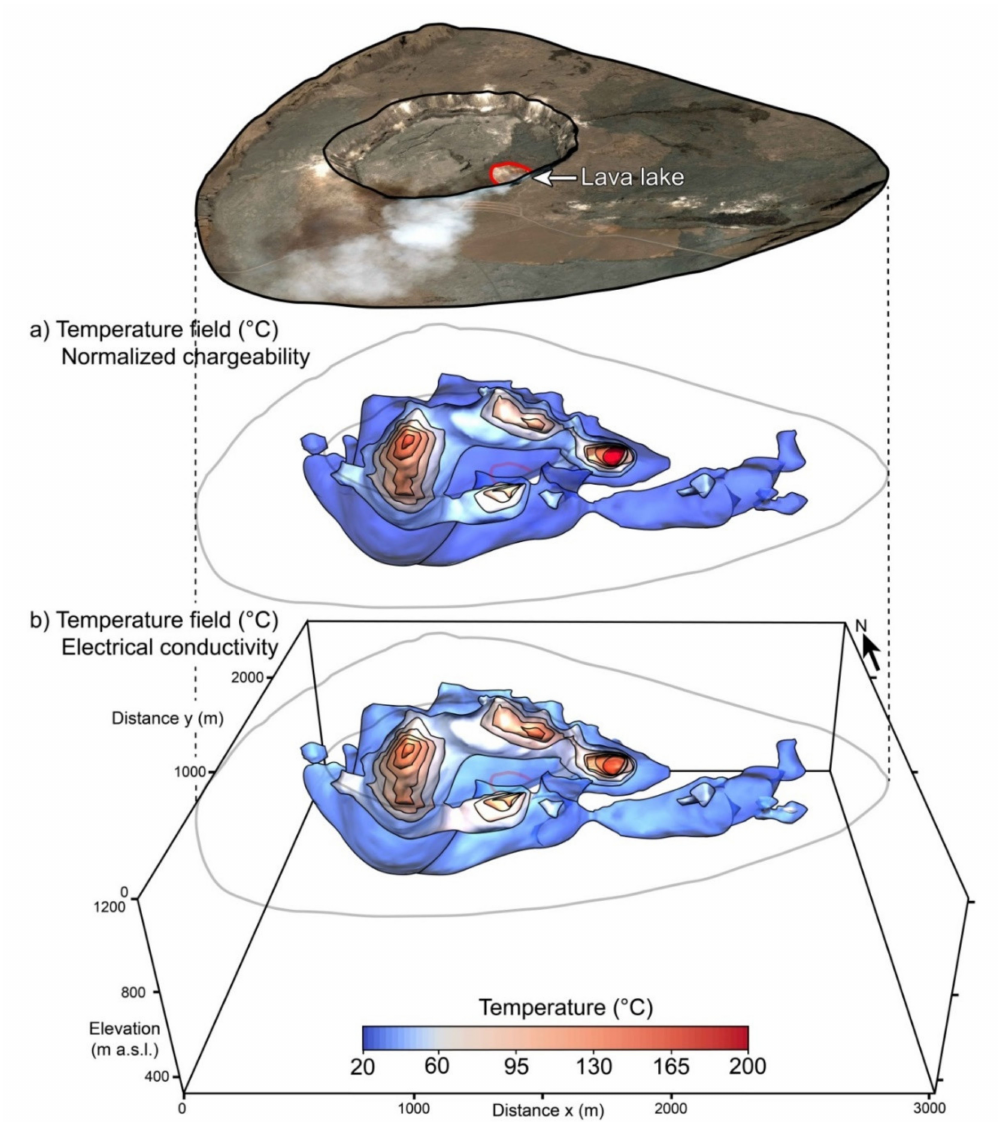
Figure 19. Imaging temperature in a shield volcano (Kilauea, Hawaii Island, Hawaii, USA, see Revil et al. [52]). ( a ) Temperature field from the conductivity distribution using electrical conductivity imaging. ( b ) Temperature field from the normalized chargeability distribution obtained by tomography. This temperature tomogram is obtained using the trends shown in Figures 9 and